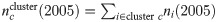
A hypothetical example of the population change in a cluster over five years.The number of inhabitants in a cell is indicated for inhabited cells shown in gray. The bold lines indicate the boundary of cluster c observed in year 2005. This cluster has nccluster(2005)=∑i∈clustercni(2005) = 10 + 20 + 30 + 40 + 50 = 150 and n˜ccluster(2010)=∑i∈clustercni(2010) = 10 + 15 + 60 = 85 inhabitants in 2005 and 2010, respectively. Although cluster c is split into different clusters in 2010, each of which extends beyond the border of cluster c determined in 2005, we neglect the split to calculate the population change in cluster c. Therefore, cluster c has lost 150–85 = 65 inhabitants in the five years.